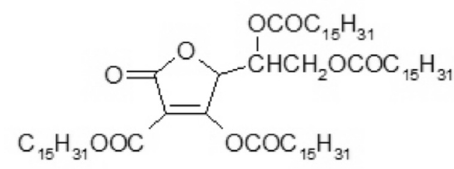
FIGURE 2 – Chemical structure of ascorbyl